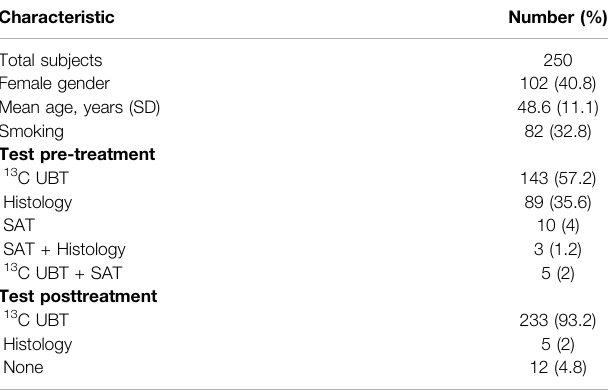
TABLE 1 | Baseline information about the study population.